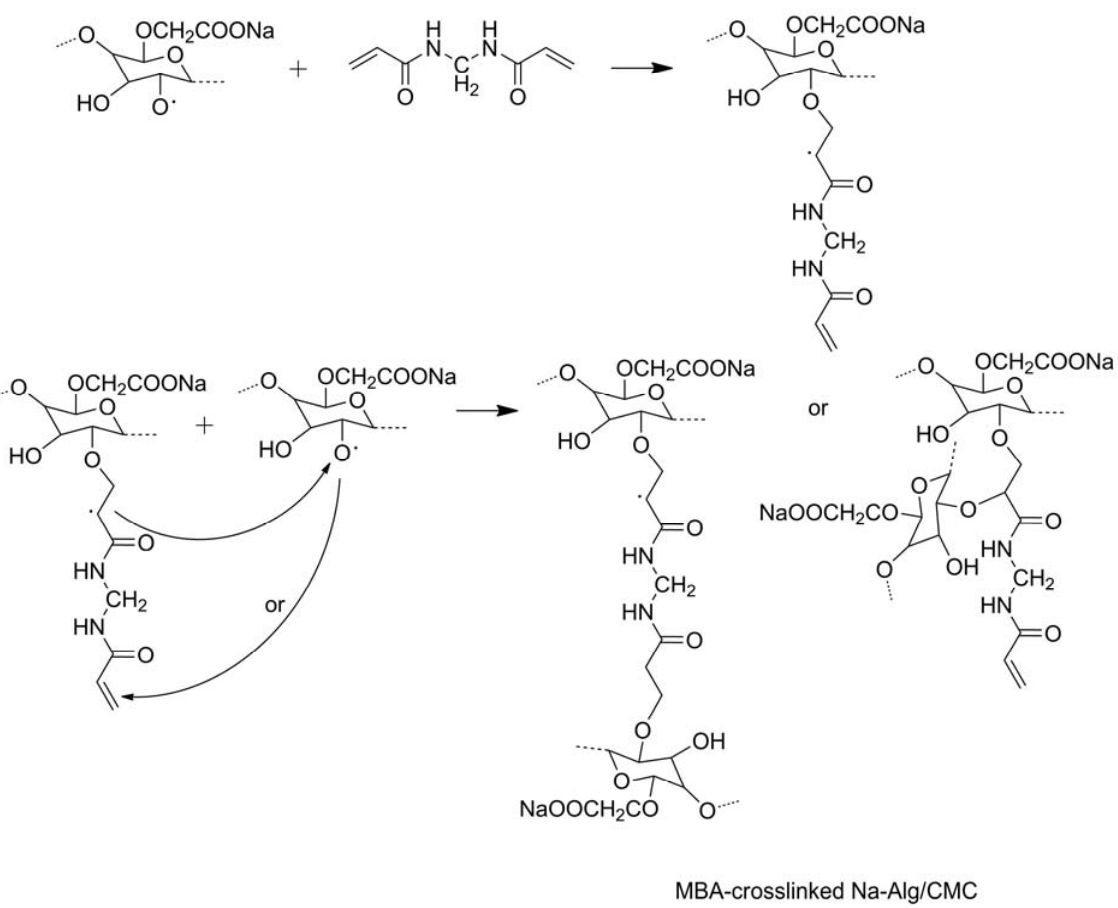
Figure 5. General mechanism for radical crosslinking of Na-Alg/CMC mixture in the presence of N , N ′ -methylene- bis -acrylamide (MBA). Reprinted with permission from [46]. Copyright 2006